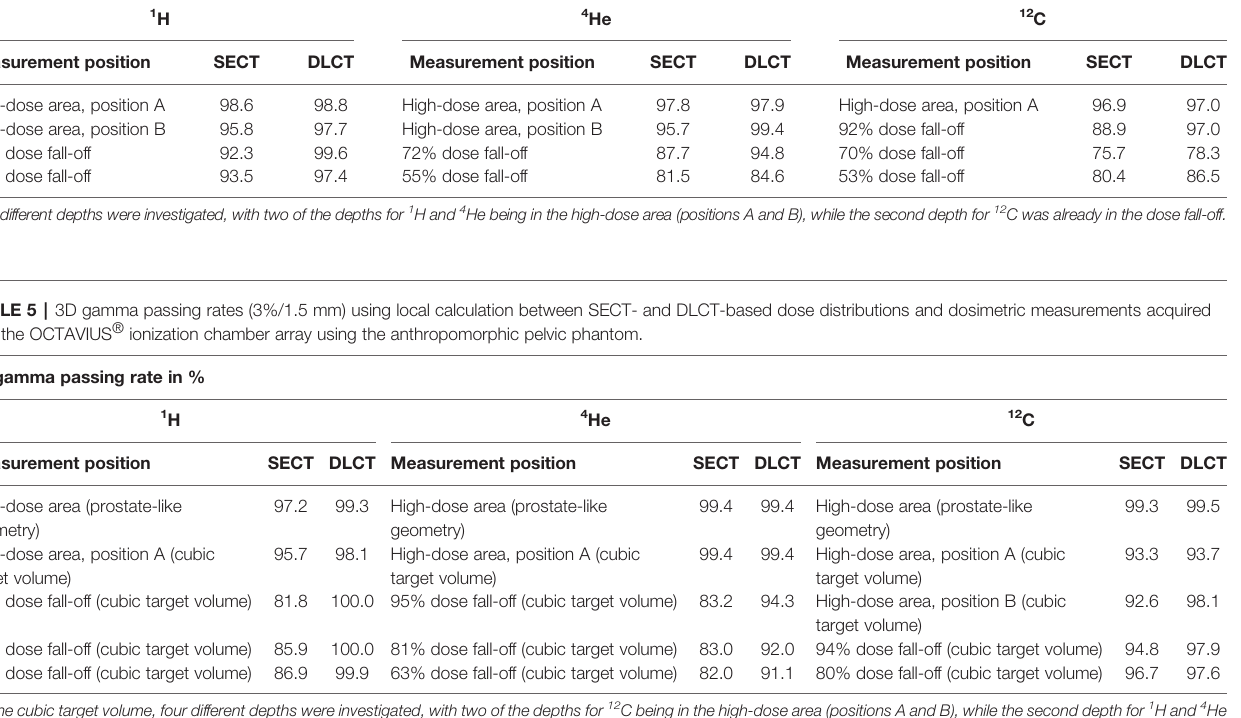
TABLE 4 | 3D gamma passing rates (3%/1.5 mm) using local calculation between SECT- and DLCT-based dose distributions and dosimetric measurements acquired with the OCTAVIUS ® ionization chamber array using the anthropomorphic head phantom. 3D gamma passing rate in %